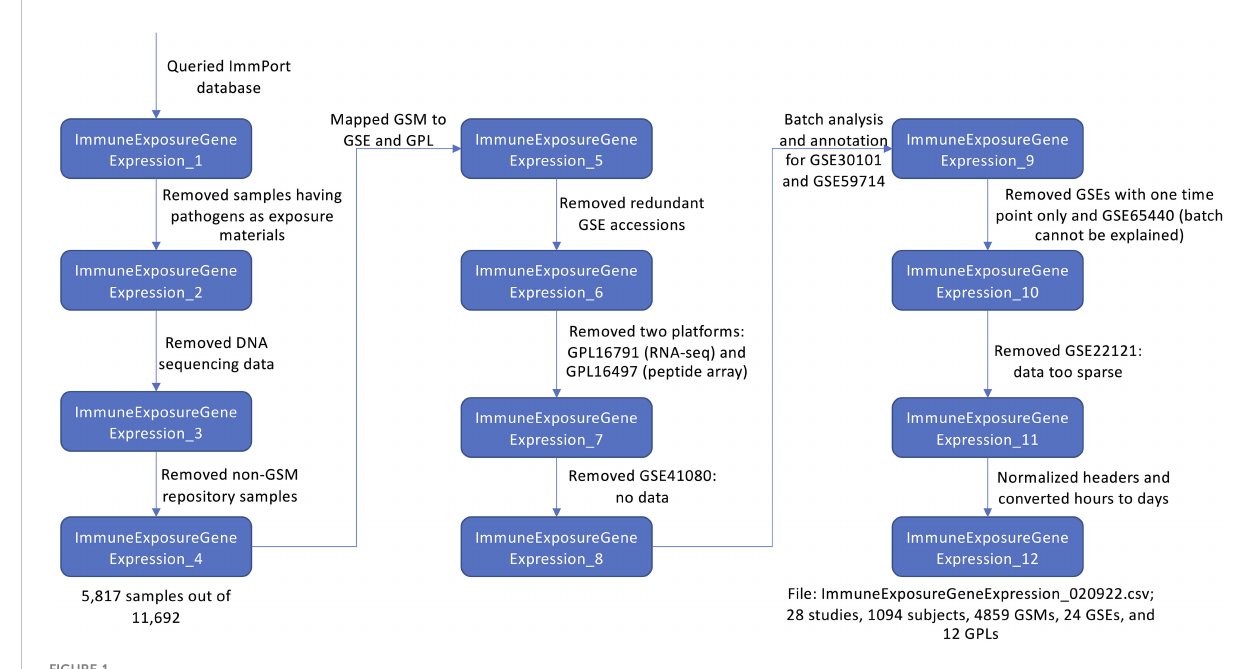
FIGURE 1 Flowchart of the work fl ow on collecting vaccination metadata from ImmPort and manual checking and